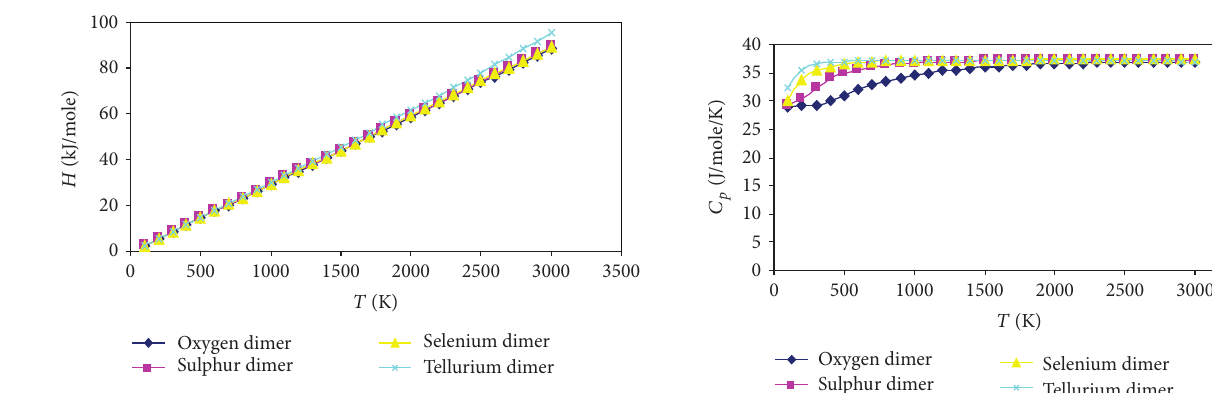
F 4: Variation of speci�c heat